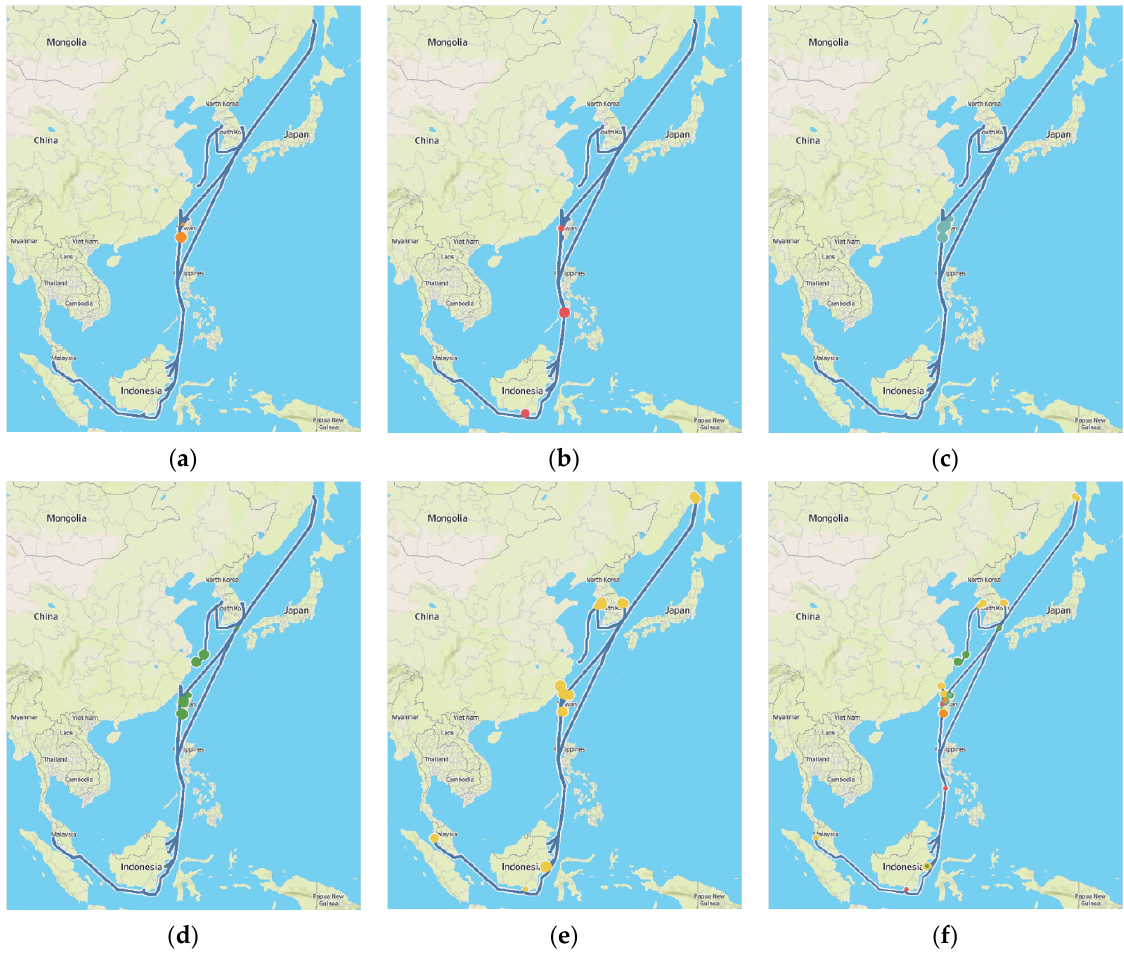
Figure 19. Anomalies plotted over the vessel routes: ( a ) cluster 1; ( b ) cluster 2; ( c ) cluster 3; ( d ) cluster 4; ( e ) cluster 5; ( f ) all cluster.